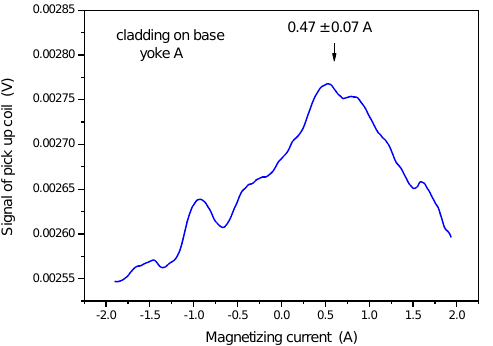
Figure 9. Signal of the pick-up coil as a function of the magnetizing current, measured on the top of cladded block by applying Yoke A.